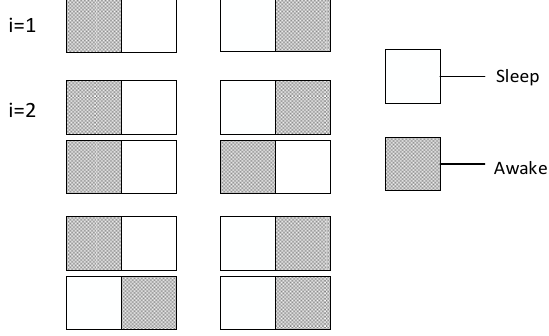
Figure 15. Example of Theorem 7 ( m = 2, i = 2).